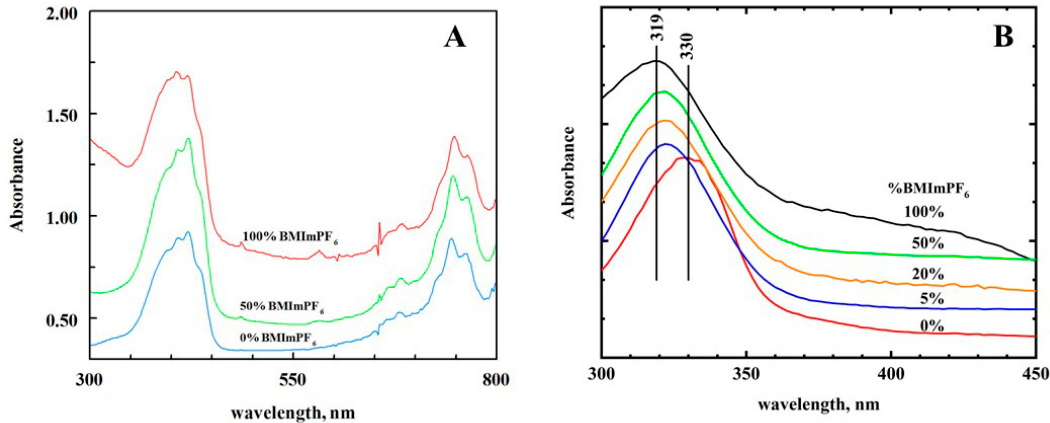
Figure 4. ( A ). Visible spectra of TCNQ − in acetonitrile (blue), 50% acetonitrile / BMImPF 6 (green), and BMImPF 6 (red). ( B ). Visible spectra of TCNQ 2 − . %BMImPF 6 in acetonitrile: 0% (red), 5% (blue), 20% (orange), 50% (green), 100% (black). Acetonitrile solutions contained 0.10 M TBAP.